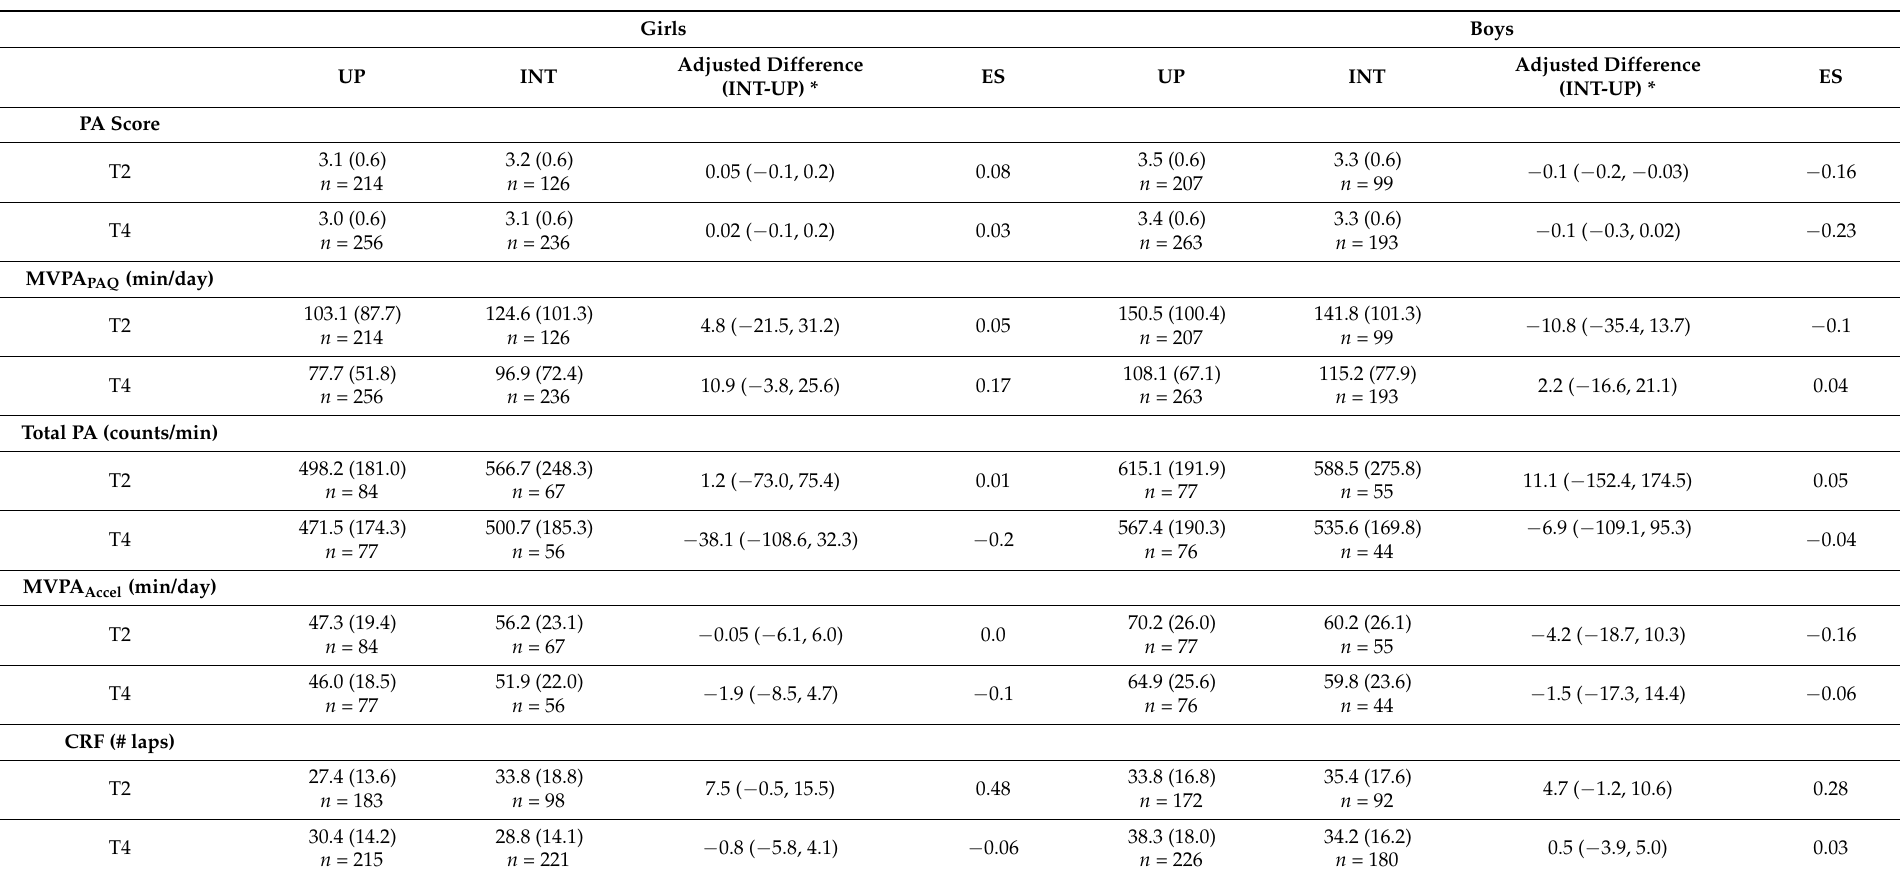
Table 5. Physical activity (PA) and cardiorespiratory fitness (CRF) at the end of year 1 (T2) and 2 (T4) in girls and boys attending usual practice (UP) compared with intervention (INT) schools. Values are means (SD) or adjusted mean difference (95% CI) using an intention to treat analysis. We include effect size (ES; Cohen’s d) as an indicator of the magnitude of the between-group